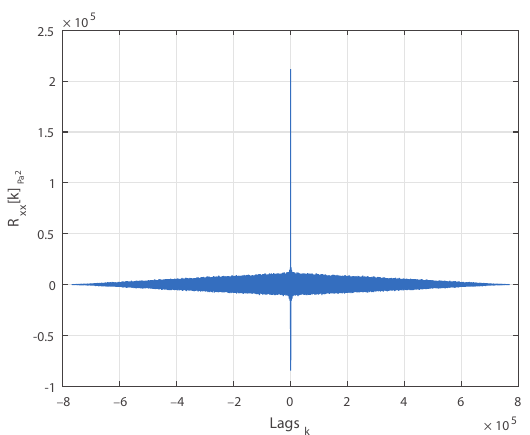
Figure 4. Autocorrelation sequence of a single 30 s long measurement.